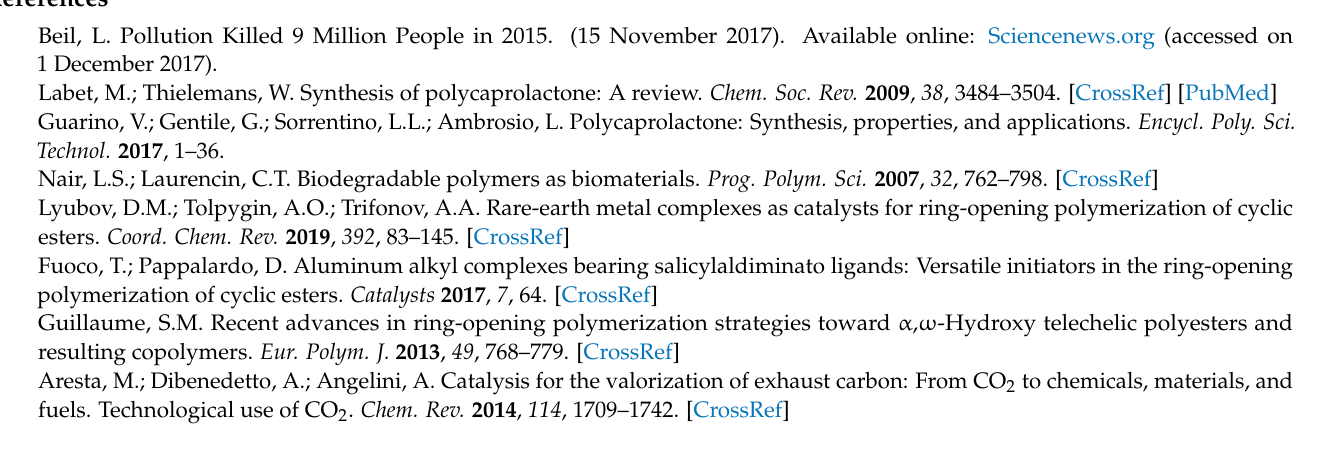
Figure S5: 1H NMR spectra of (a) ε -caprolactone (b) poly- ε -caprolactone in CDCl3 using 300 MHz NMR spectrometer. Figure S6: The 1H NMR spectra showing the proton signals of (A) styrene oxide and (B) mixture of styrene oxide and styrene carbonate in the range of δ 6.0~2.0. Table S1: The summary of X-ray crystal data for L1H~L4H, 1, 3, and 4, Table S2: Selected bond lengths and angles for L1H~L4H, 1, 3, and 4, Crystallographic data for the structures reported in this paper have been deposited with the Cambridge Crystallographic Data Centre as supplementary publications